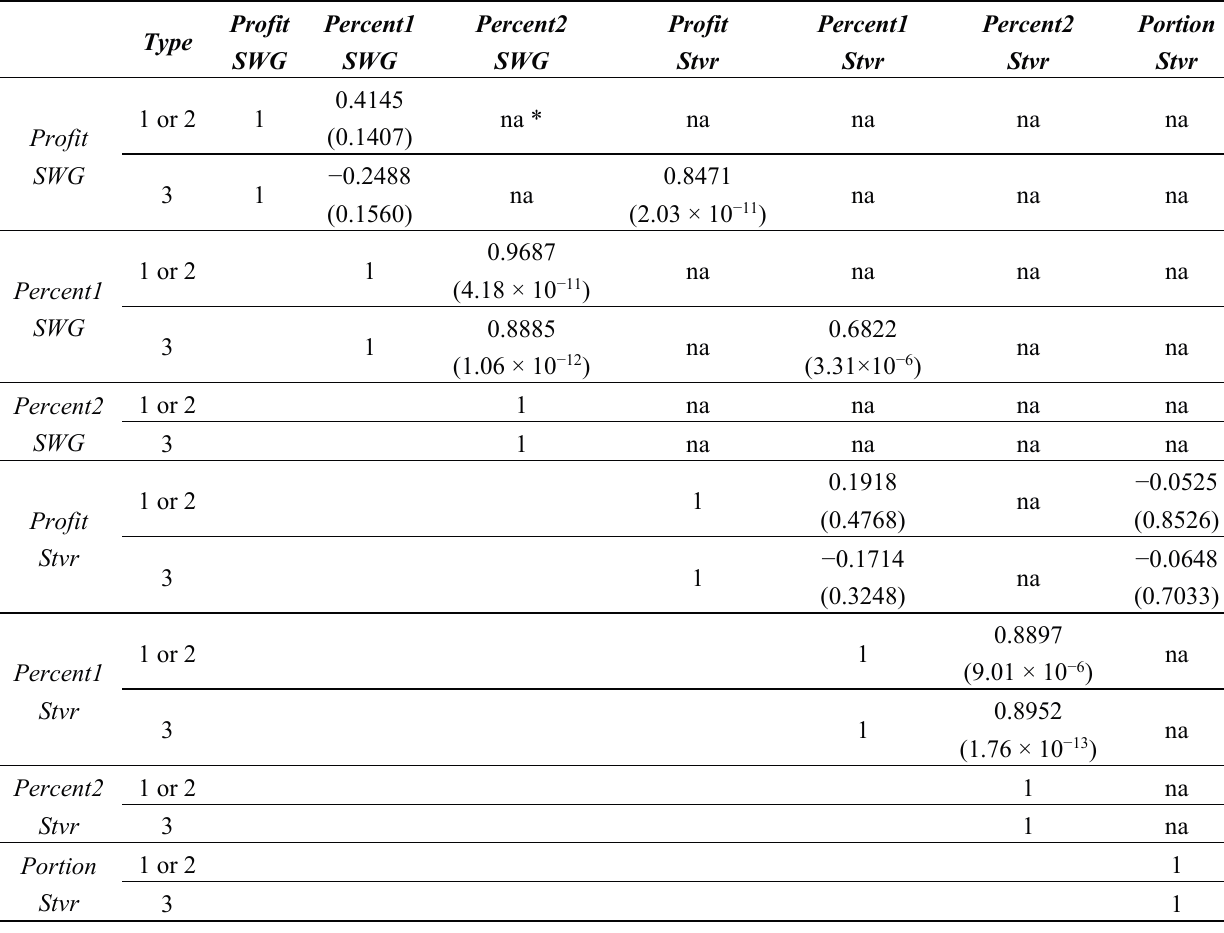
Table A2. Pearson’s r ( p -value) between the parameters characterizing farmers’